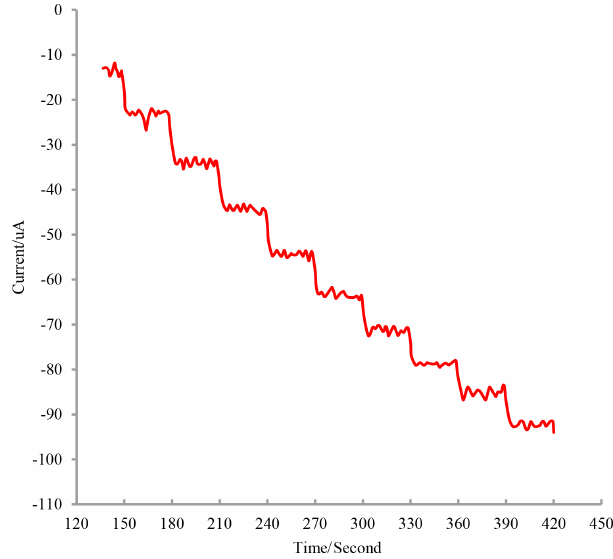
Figure 8. Constant potential amperometry responses of the Aeromonas hydrophila DNA biosensor during 137–415s; rotating speed was 500rpm. This test was performed in a 10mL electrolyte cell (50mM Tris-HCl, 100mM NaCl, 15mM KCl, 10mM MgCl 2 , and 5% ethanol;